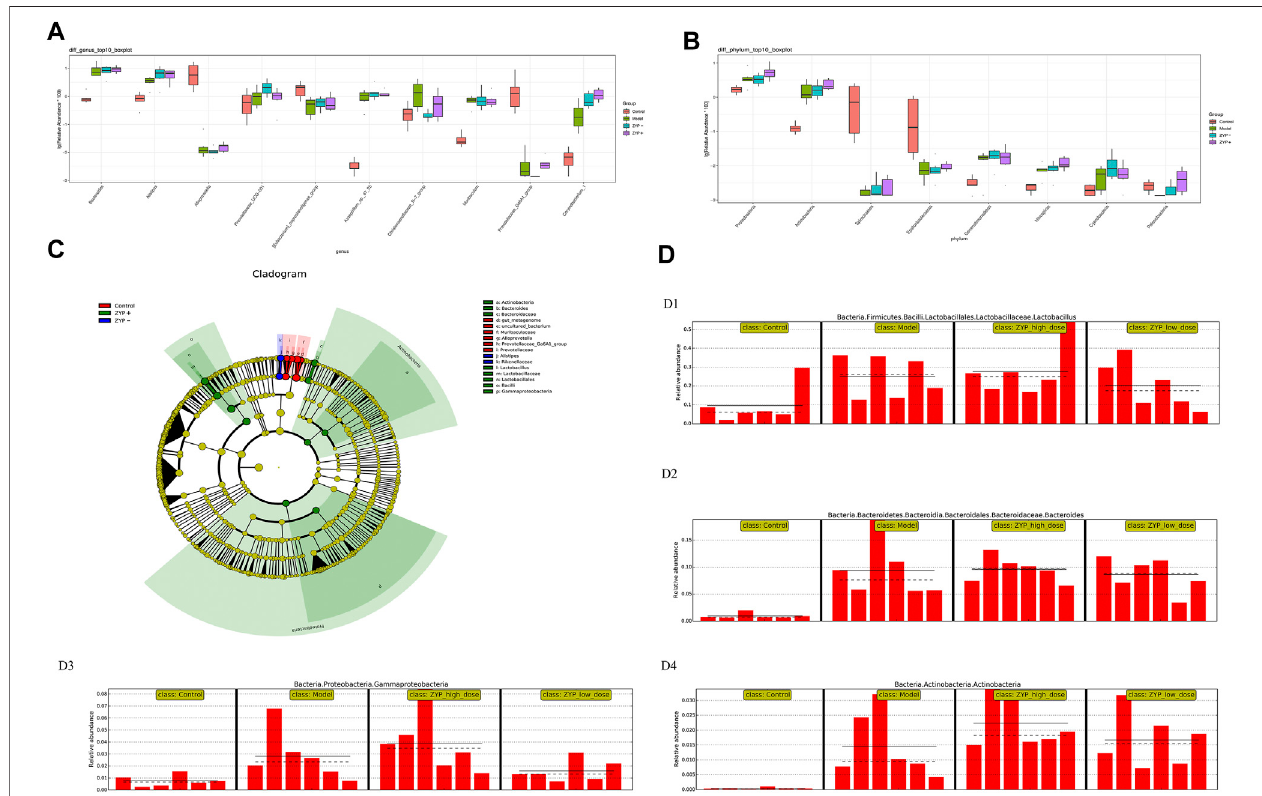
FIGURE 7 | Statistical analysis of microbial multivariate. (A) One-way ANOVA analysis of genus level; (B) One-way ANOVA analysis of phylum level; (C) Example diagram of annotated branches of different species; (D) Histogram of relative abundance. D1, Lactobacillus ; D2, Bacteroides ; D3, Gammaproteobacteria ; D4, Actinobacteria . The solid line is the mean value of the relative abundance and the dashed line is the median value of relative abundance.